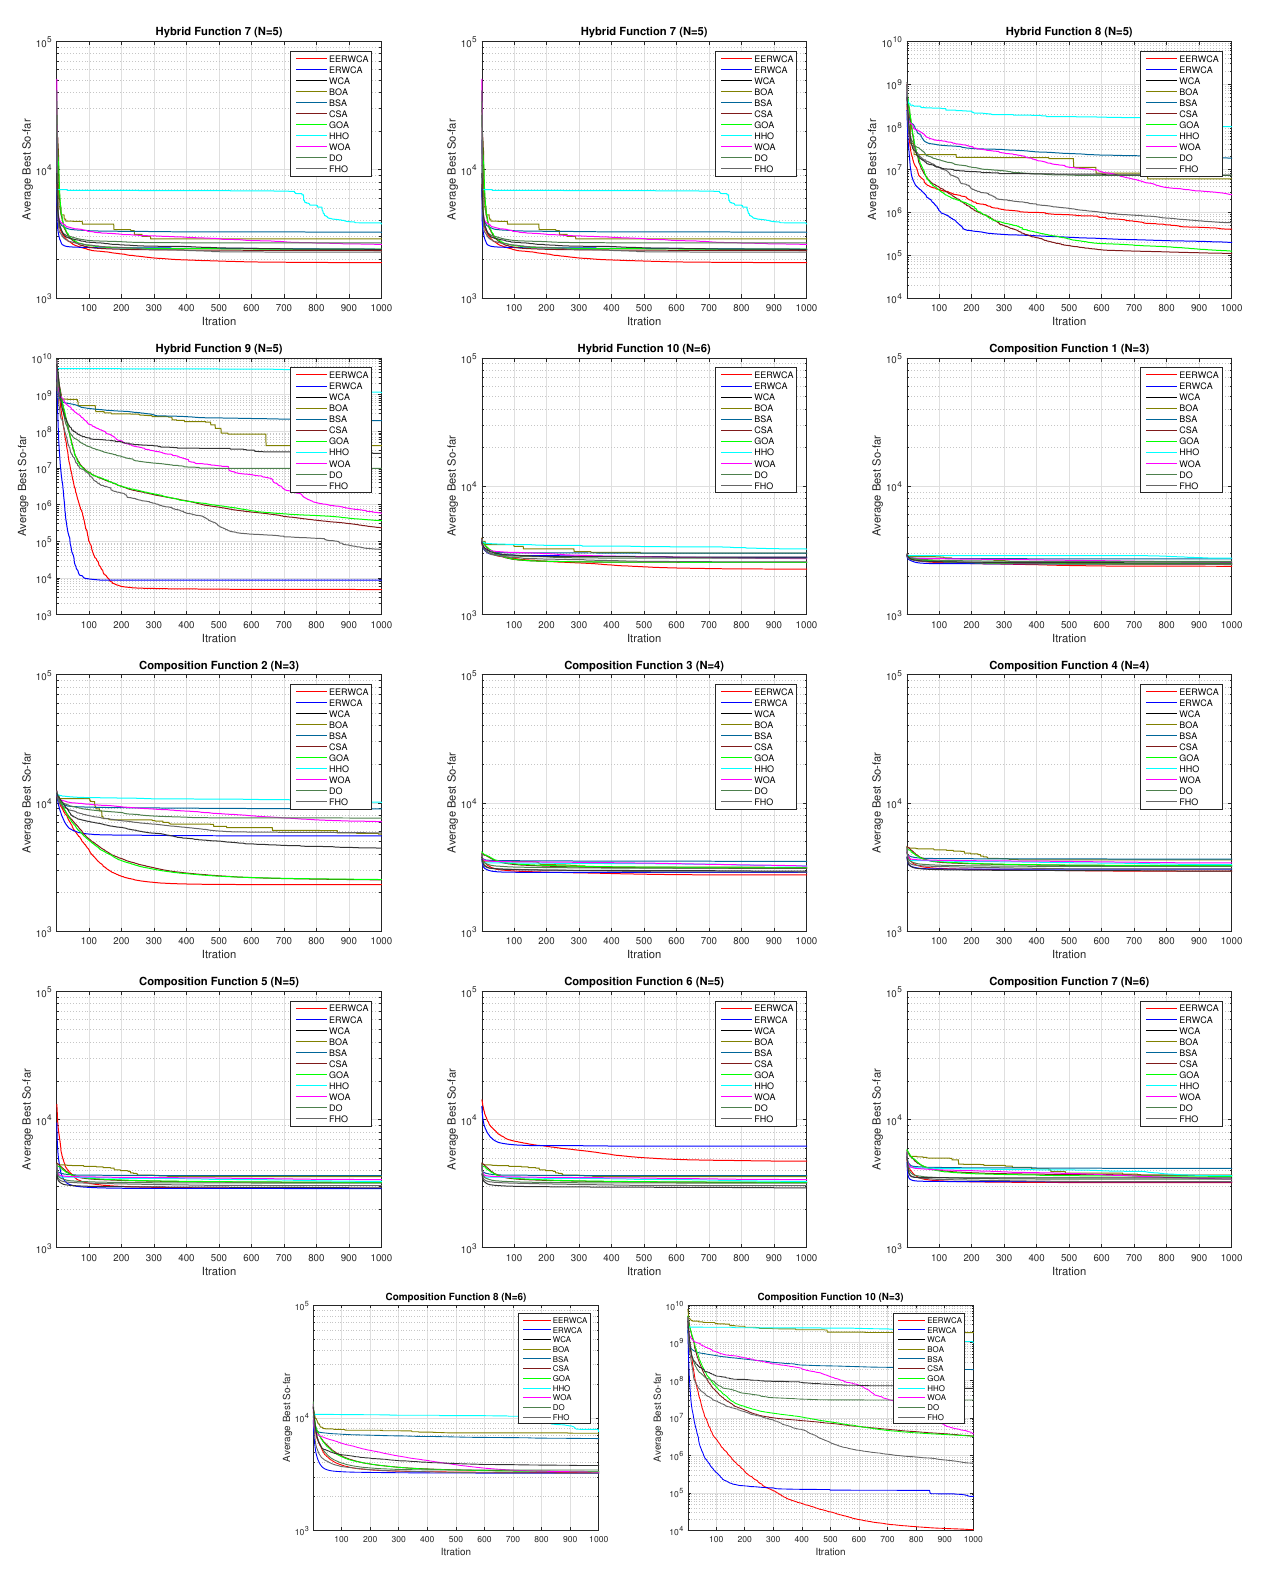
Figure 3. Convergence curve of some functions from F16–F30 for all algorithms using CEC2017 and dim =